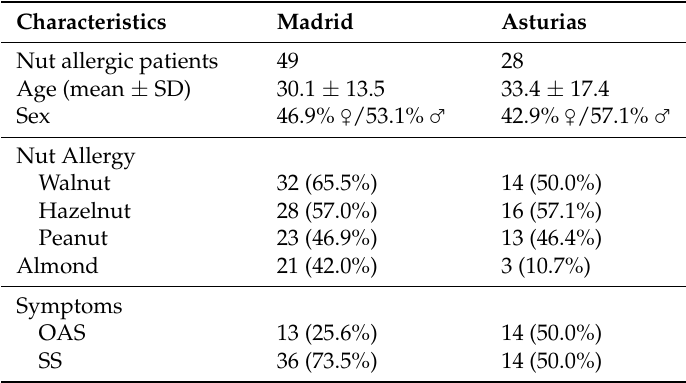
Table 5. General characteristics of nut allergic